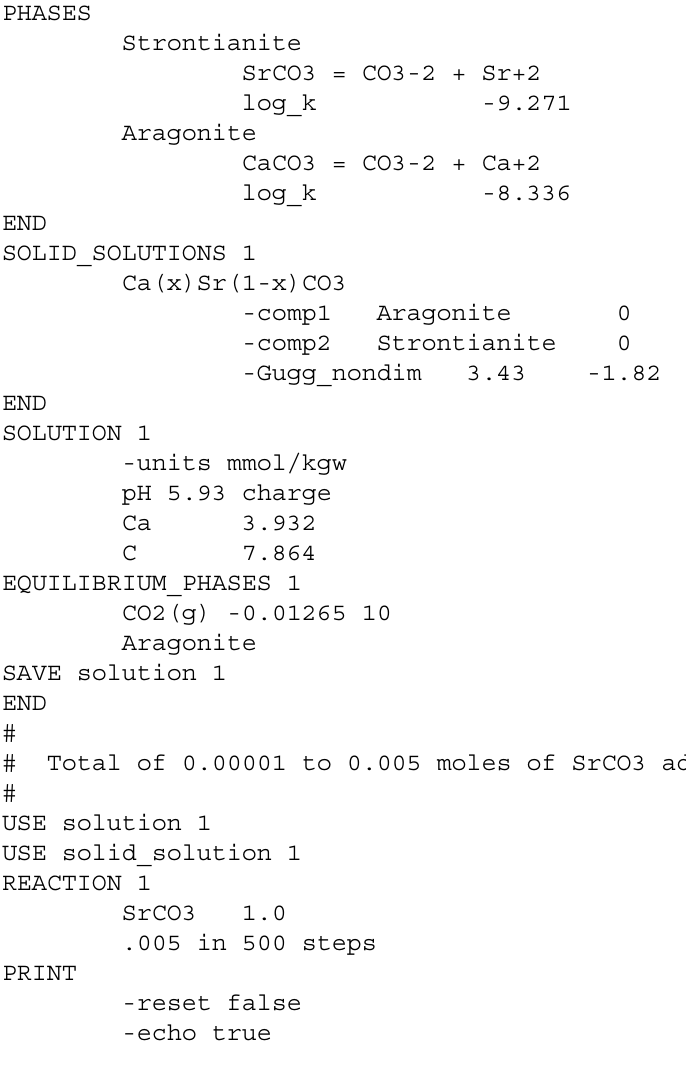
Table 29. Input file for example 10. TITLE Example 10.--Solid solution of strontianite and